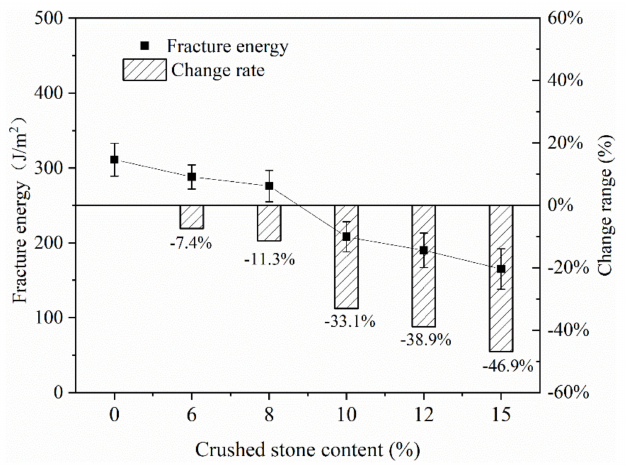
Figure 12. E ff ect of crushed stone content on fracture